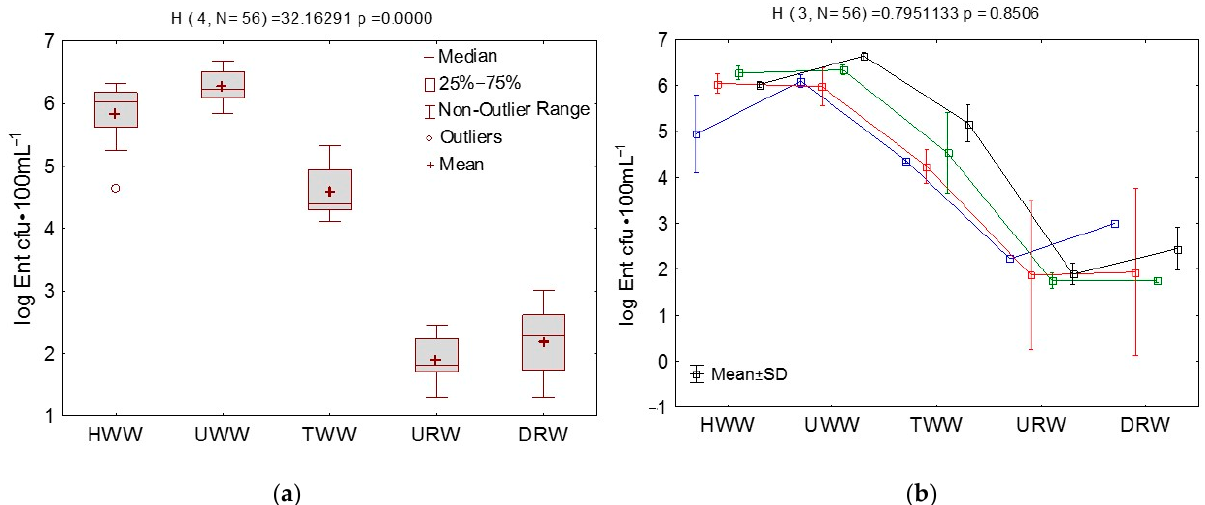
Figure 1. Enterococcus counts [log Ent cfu · 100 mL − 1 ] determined by the culture-dependent method in river water and wastewater sampled from different ( a ) sites and ( b ) seasons during the study. Kruskal–Wallis test (ANOVA), SD—standard deviation; N —number of samples; p —significance level.